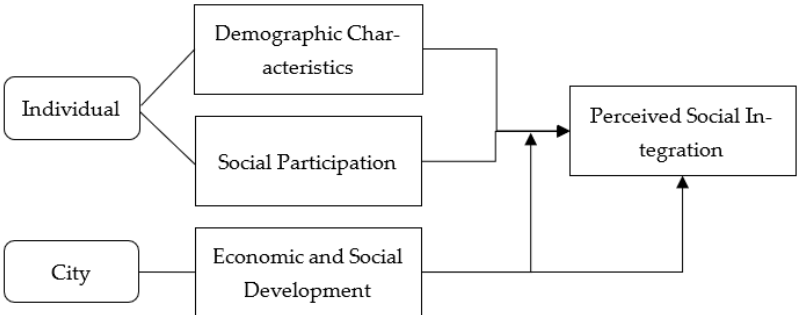
Figure 2. Model of perceived social integration of new urban